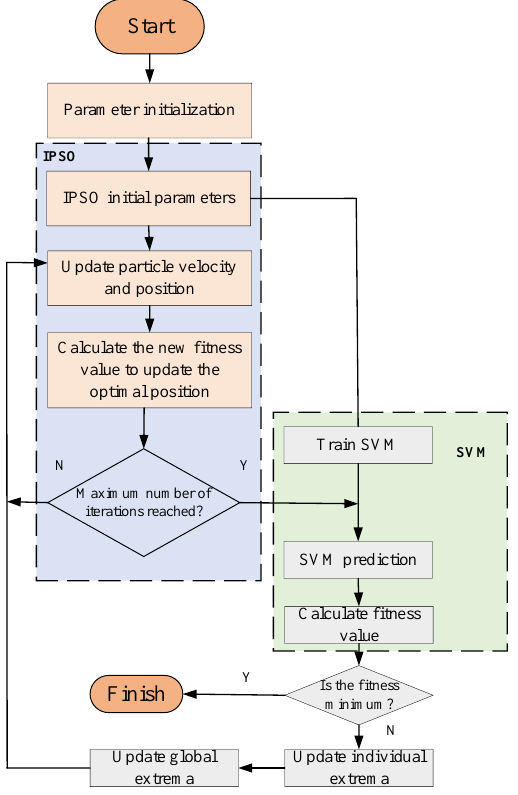
Figure 5. IPSO-SVM fault diagnosis flow chart.